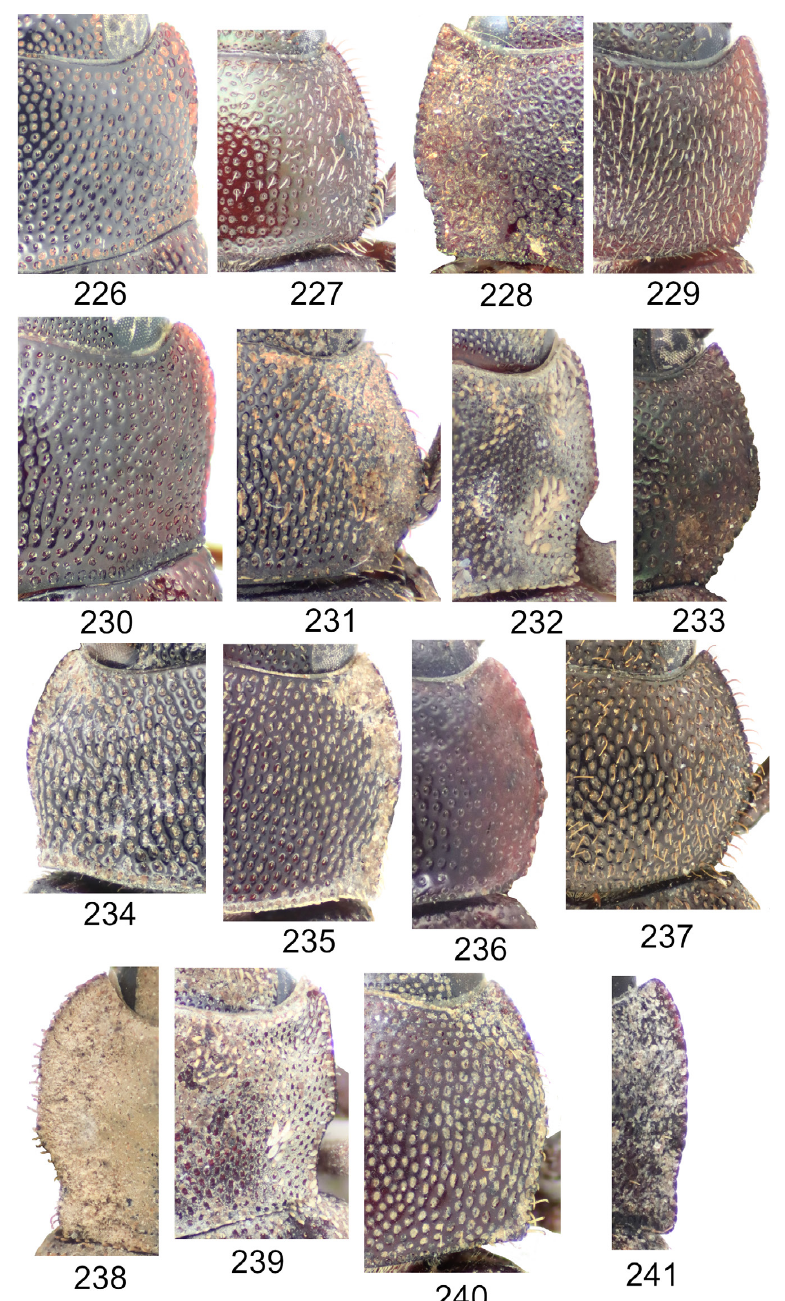
Figs 226–241. Papuan and Wallacean Maechidius Macleay, 1819, pronotum, dorsal view. 226 . M. lineatopunctatus Frey, 1969, holotype, ♂ (NHMB). 227 . M. lobaticeps Frey, 1969, ♂